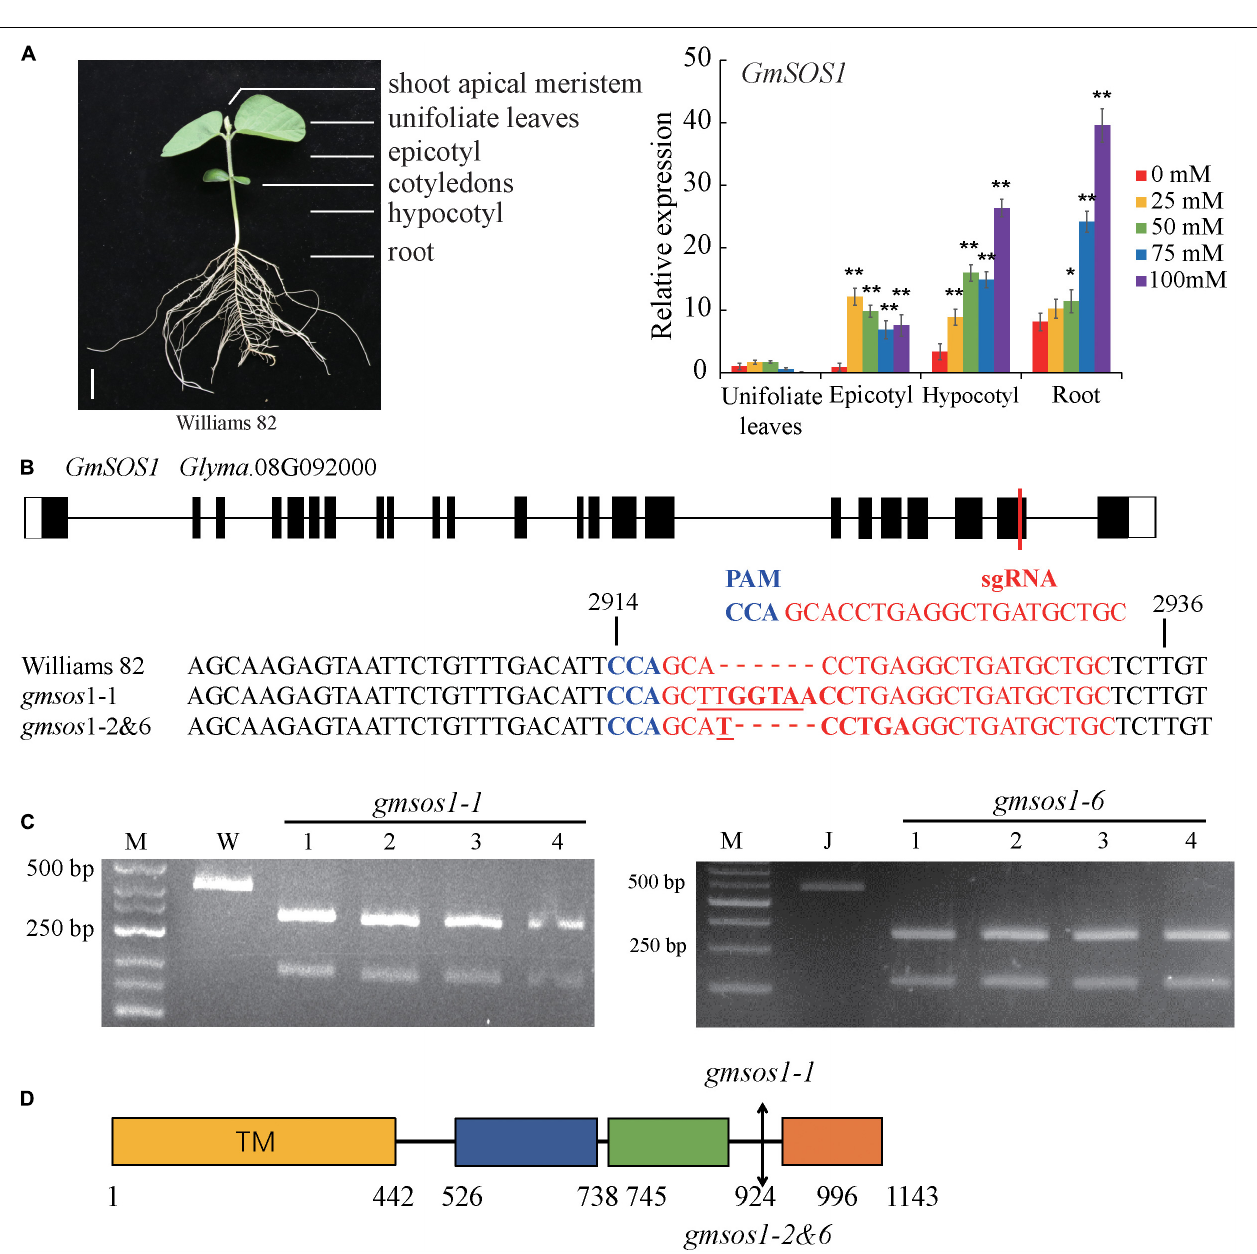
FIGURE 3 | Generation of gmsos1 mutants using CRISPR/Cas9 system. (A) The relative transcript levels of GmSOS1 in different tissues as determined by qRT-PCR analysis. The RNA samples were from unifoliate leaf, root, epicotyl, and hypocotyl of Williams plants that are subjected to 0, 25, 50, 75, or 100 mM NaCl. Values are means ± SD ( n = 3). Significant differences in mean values relative to the mean value of unstressed plants in each tissue are indicated by Student’s t -tests (* p < 0.05, ** p < 0.01). (B) Generation of mutations in GmSOS1 (Glyma.08G092000) by CRISPR/Cas9 using single-guide RNA (sgRNA). The sgRNA sequence is in red, and the protospacer adjacent motif (PAM) sequence is in blue. The coding sequence of GmSOS1 that is complementary to the sgRNA and its flanking sequences are compared with the corresponding sequences in gmsos1-1 , gmsos1-2 , and gmsos1-6 mutants. The sequence in bold in gmsos1-1 is the Bst E II digestion site (GGTNACC) and the sequence in bold in gmsos1-2 and gmsos1-6 is a Hpy 188 III digestion site (TCNNGA). The numbers (2,914 and 2,936) above the nucleotide sequences are relative to the start codon of GmSOS1. (C) Cleaved amplified polymorphic sequence (CAPS) markers were used to identify the mutations in the gmsos1 mutants. PCR products amplified by specific primers from Williams (W) and the gmsos1-1 plants were digested by BstE II (left panel). PCR products amplified by specific primers from Jack and the gmsos1-6 plants were digested with Hpy188 III (right panel). Primers used in this experiment were listed in Supplementary Table 1 . M represents DNA ladder. (D) The mutations identified in the gmsos1 mutants and potential effects on the GmSOS1 protein. Yellow box (from 1 to 442 aa), putative N-terminal transmembrane domain; blue box (from 526 to 738 aa), putative intracellular domain homologous to AtNHX8; green box (from 745 to 924 aa), putative C-terminal cyclic nucleotide (cNMP)-binding domain; orange box (from 996 to 1,143 aa), putative self-inhibition domain.